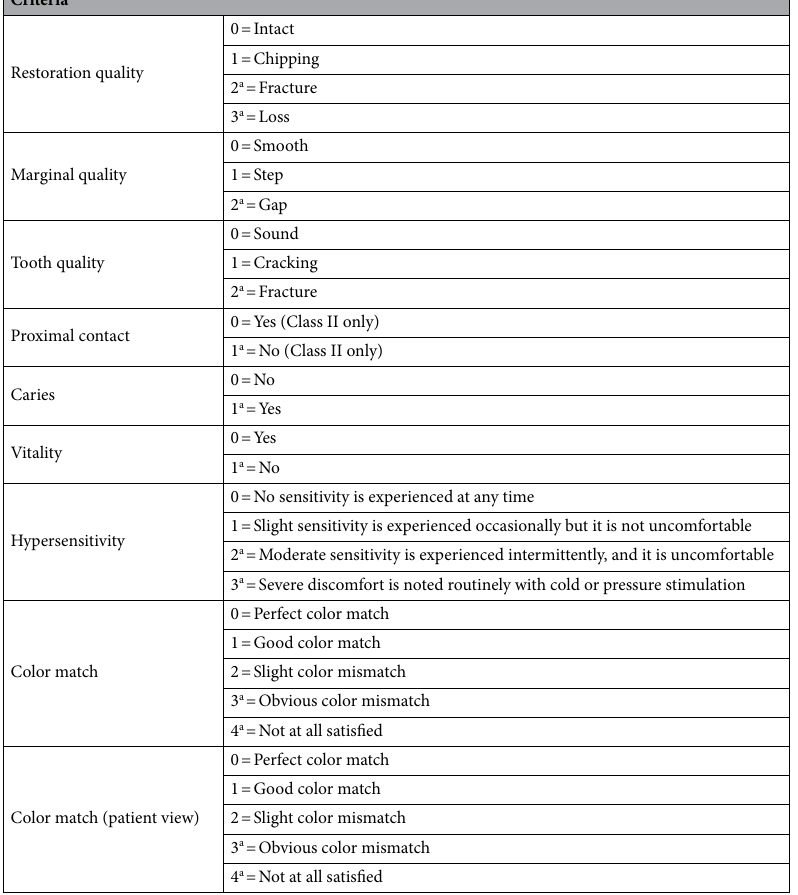
Table 3. Modified USPHS criteria for evaluation of the self-adhesive bulk-fill restorations. a Unacceptable scores.